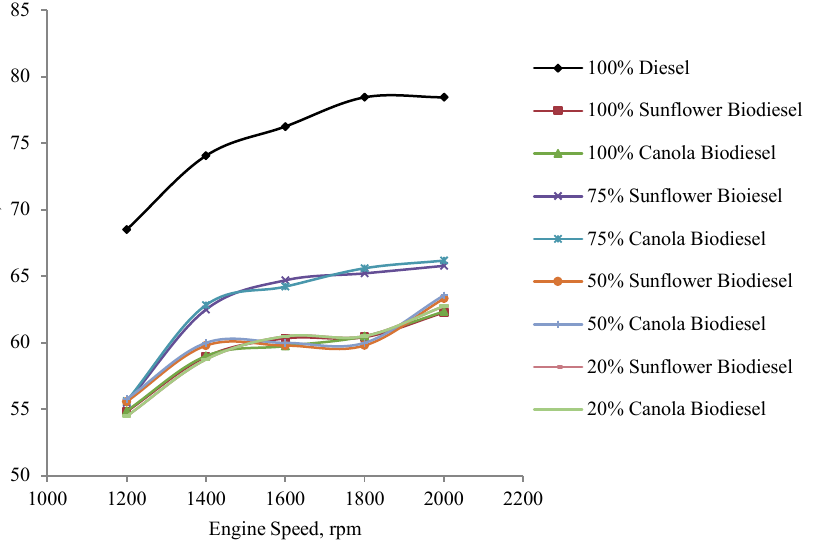
Fig. 8. Simulated Power performance against engine speed.